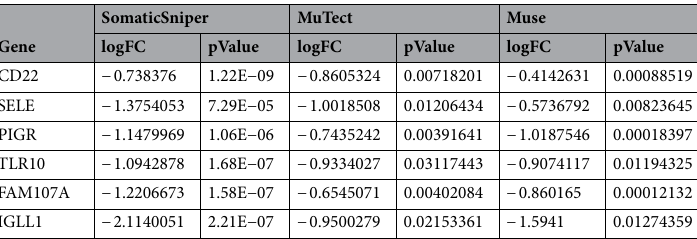
Table 2. DEGs are verified in TMB evaluation of different analysis pipelines.